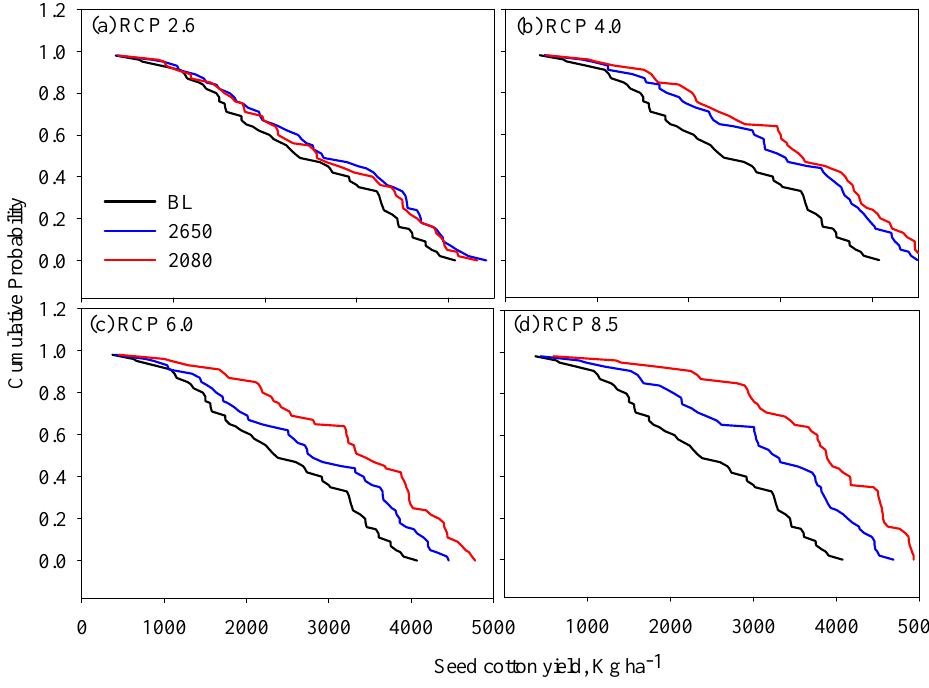
Figure 10. Simulated impacts of CO 2 concentration in the air alone on rainfed seed cotton yield under RCP 2.6 ( a ), 4.5 ( b ), 6.0 ( c ), and 8.5 ( d ) emission scenarios in 2050 and 2080. The projected temperature and rainfall changes were not considered.